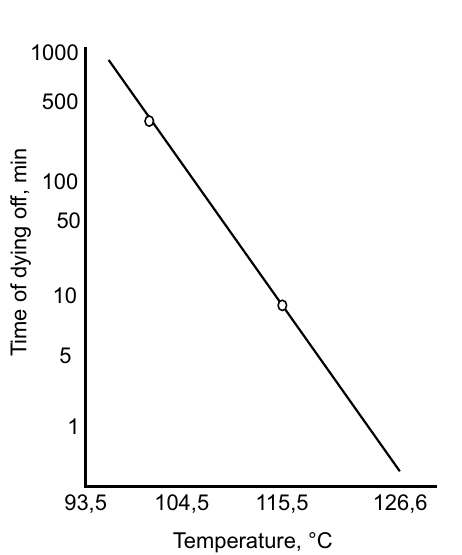
Fig. 3. Dependence of dying time on temperature in semi-logarithmic coordinates